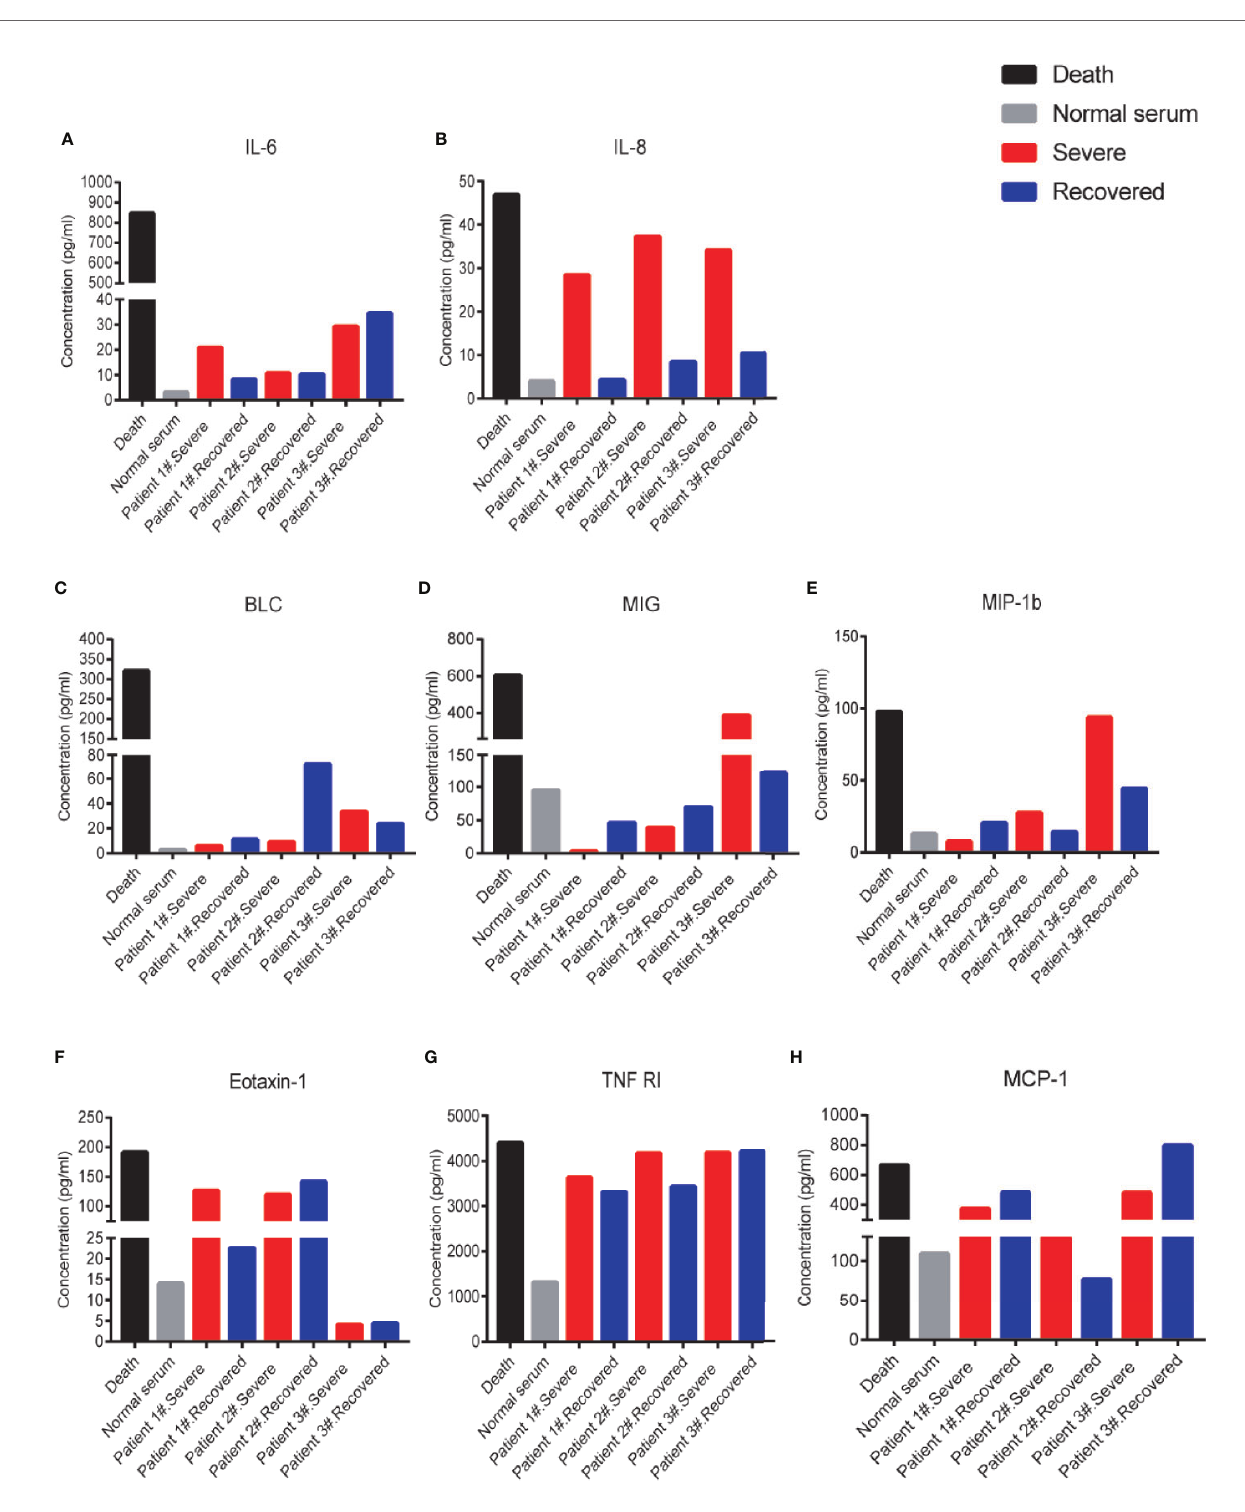
FIGURE 2 | Cytokine levels in COVID-19 severe and recovered patients ’ sera. Cytokine levels of IL-6 (A) , IL-8 (B) , BLC (C) , MIG (D) , MIP-1b (E) , Eotaxin-1 (F) , TNF RI (G) , and MCP-1 (H) in COVID-19 severe and recovered patients ’ sera. Every column represents one serum sample of COVID-19